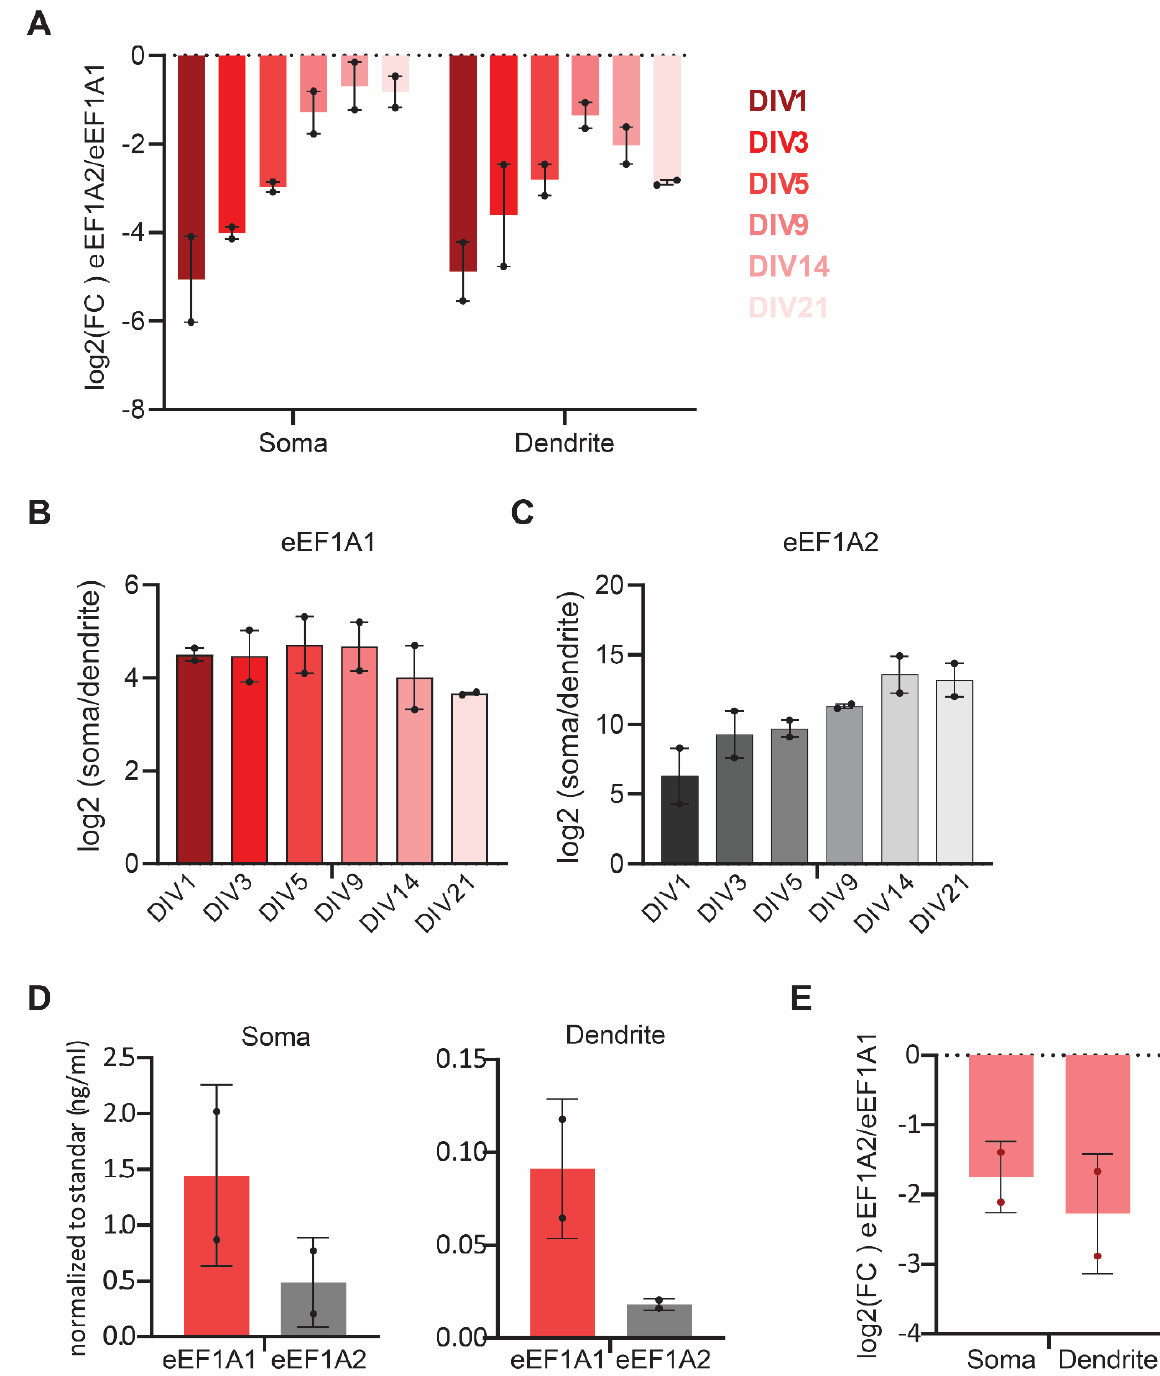
Figure 5. Relation of eEF1A1 and eEF1A2 mRNA subcellular localization over neurodevelopment. ( A ) Fold change in the expression of eEF1A2 vs. eEF1A1. Plot of the log2 of the ratio between eEF1A2 and eEF1A1 mRNA molecule density at the indicated DIVs in somas and in dendrites from experiments quantified in Figures 2 and 3. ( B , C ) Fold change in the somatic versus the dendritic number of eEF1A1 ( B ) and eEF1A2 ( C ) mRNAs at the indicated DIVs. ( D ) RT-QPCR to detect eEF1A1 and eEF1A2 mRNAs from total RNA extracted from the soma or neurite fractions of DIV21 neurons was normalized to a standard curve obtained from serial dilutions (50, 5, 0.5, and 0.05 ng/mL) of total cDNA. Average and SD of two biological replicas. ( E ) Plot of the log2 of the ratio between eEF1A2 and eEF1A1 mRNA relative concentrations in somas and dendrites obtained from ( D